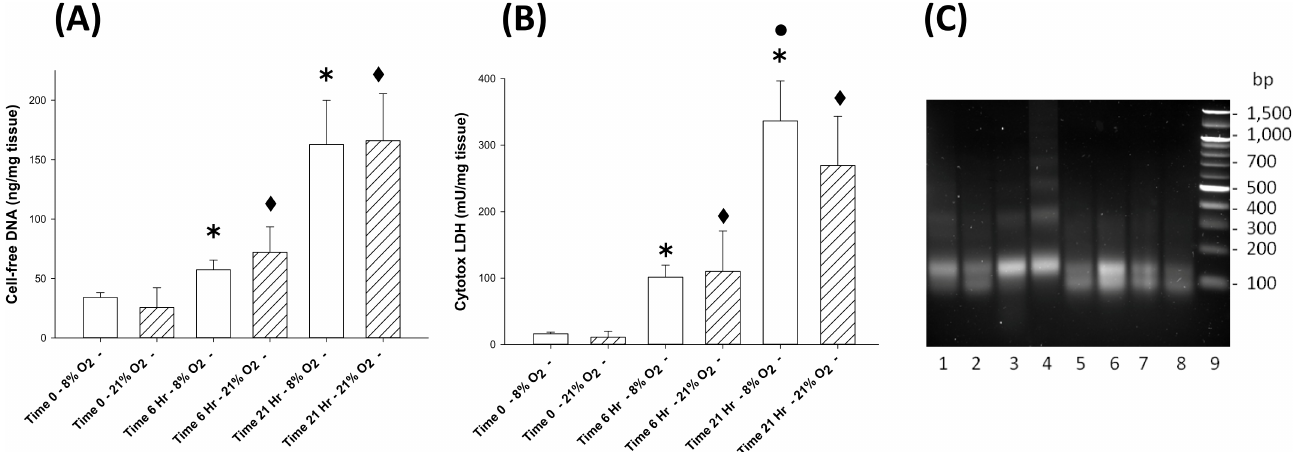
Fig 1. A) Cell-free DNA response over time: Bar graph demonstrating cell-free DNA (cfDNA) releaseby placentalexplantscultured in 8% O 2 conditions(open bars) and in 21% O 2 conditions (hatchedbars) from time zero to 21 hours. Data reportedin mean ± standarddeviation(S.D.), N = 4–68, * = p < 0.05 comparedto time zero/8% O 2 and ◆ = p < 0.05 comparedto time zero/21%O 2 . B) Cytotox LDH response over time: Bar graph demonstrating LDH (by Cytotox assay) release by placentalexplantsculturedin 8% O 2 conditions(open bars) and in 21% O 2 conditions (hatched bars) from time zero to 21 hours. Data reportedin mean ± standarddeviation(S.D.), N = 4–19, * = p < 0.05 compared to time zero/8% O 2 , ◆ = p < 0.05 comparedto time zero/21%O 2 and ● = p < 0.05 comparedto 21% O 2 at 21 hours. C) Cell-free DNA horizontal gel: Image of a